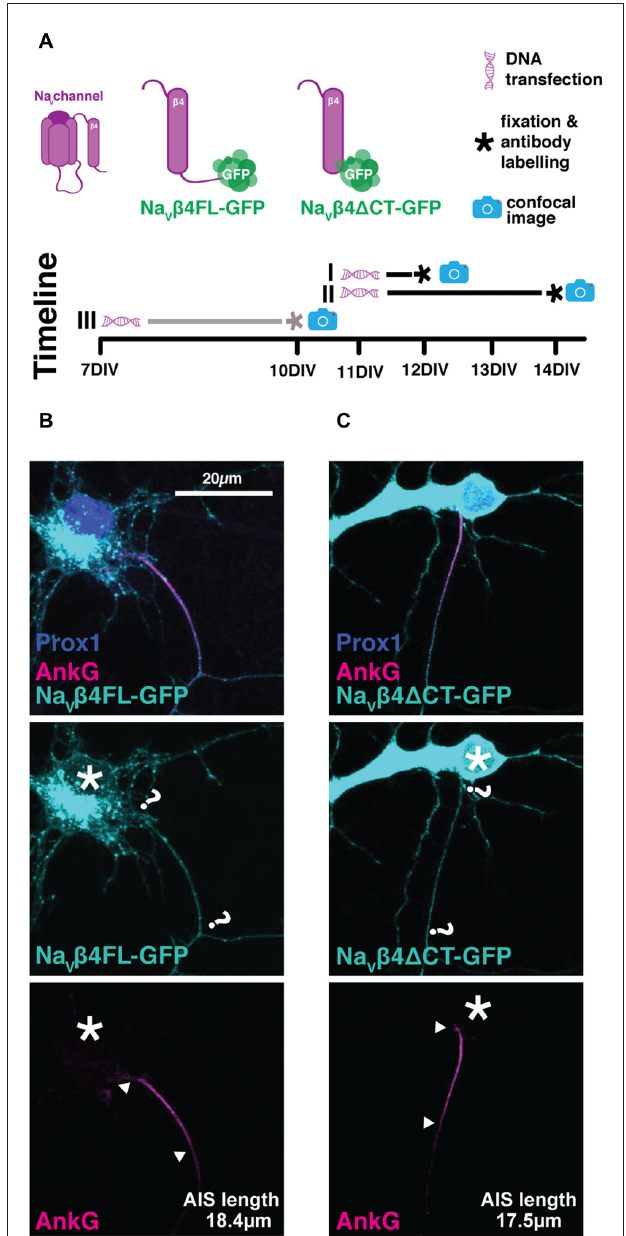
FIGURE 5 | Lack of AIS specificity with the Na V β 4-GFP constructs. (A) Diagram of experimental timeline for the three transfection methods attempted (see Table 2 ); gray line highlights method used for the cells displayed in panels (B,C) . (B) Maximum intensity projection of the usual expression pattern of Na V β 4FL-GFP (cyan) and lack of co-localization with AIS marker AnkG (magenta). Asterisks, soma; question marks, presumptive location of Na V β 4-GFP AIS; arrowheads, AnkG AIS start and end positions. (C) As in (B) , but for the Na4 ∆ CT-GFP construct.